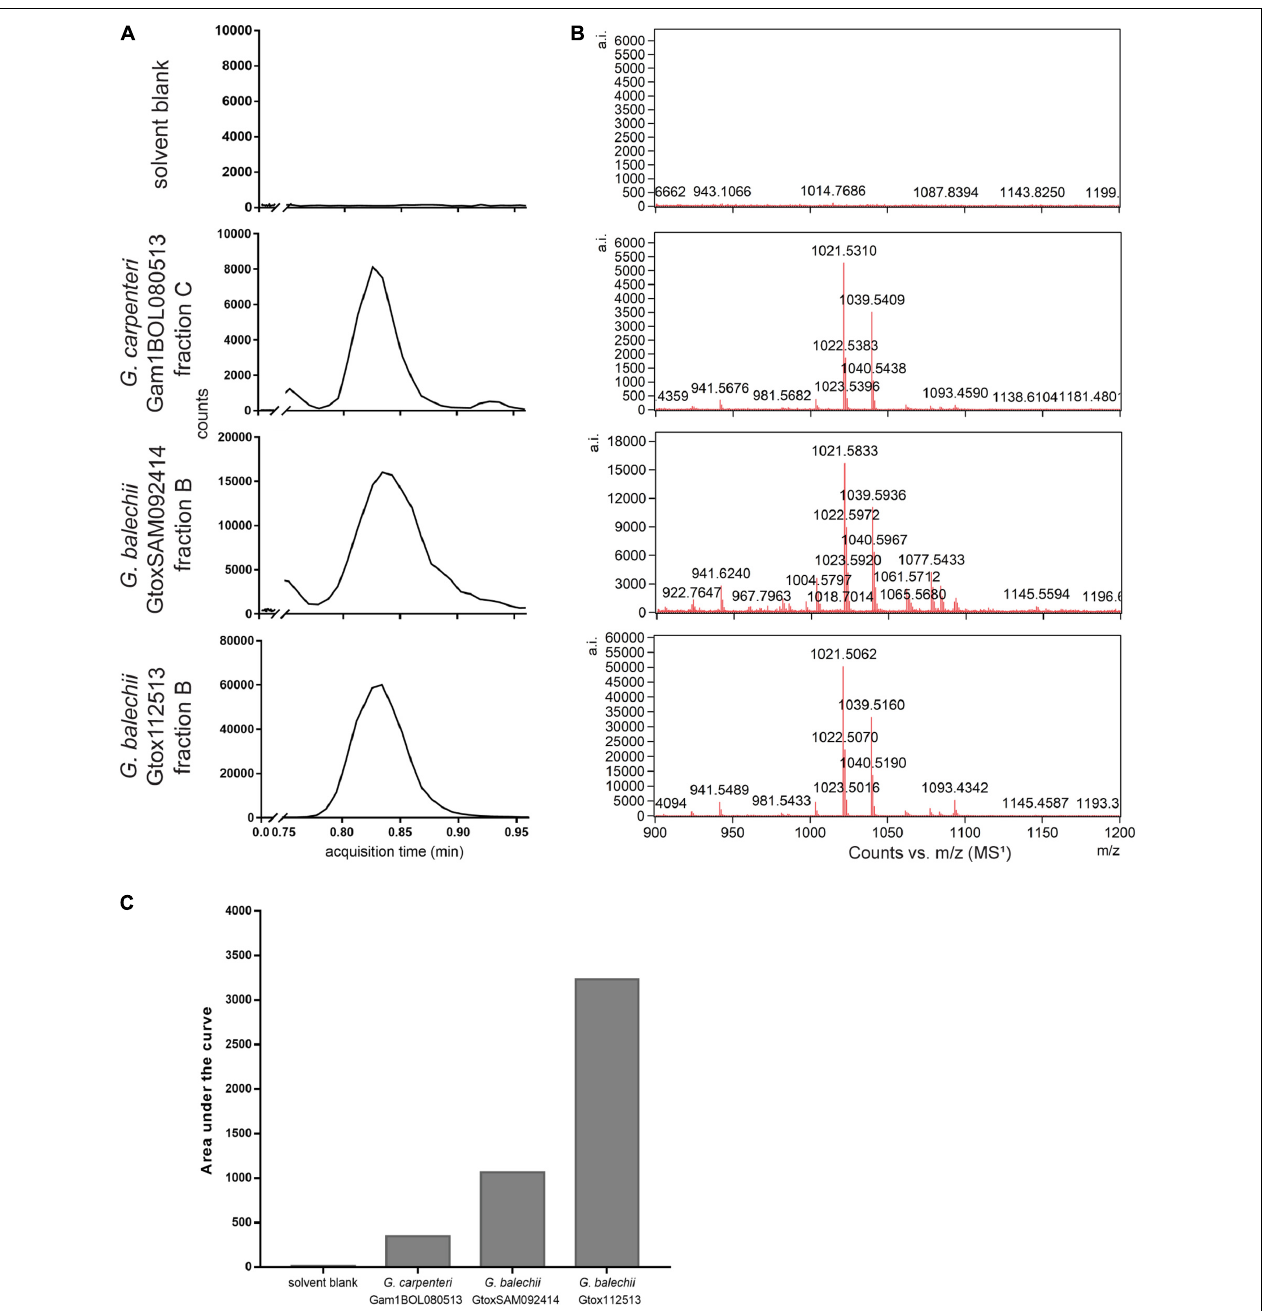
FIGURE 7 | LC-HRMS chromatograms (A) of the Gambierdiscus Florisil R (cid:13) fractions (t R 0.75–0.95 min) and MS 1 spectra corresponding to 44-methylgambierone (B) . Relative amount of 44-methylgambierone was semi-quantified by integrating the area under the chromatogram peaks in (A) along with the solvent blank (C) . G. balechii Gtox112513 contained the highest amount of